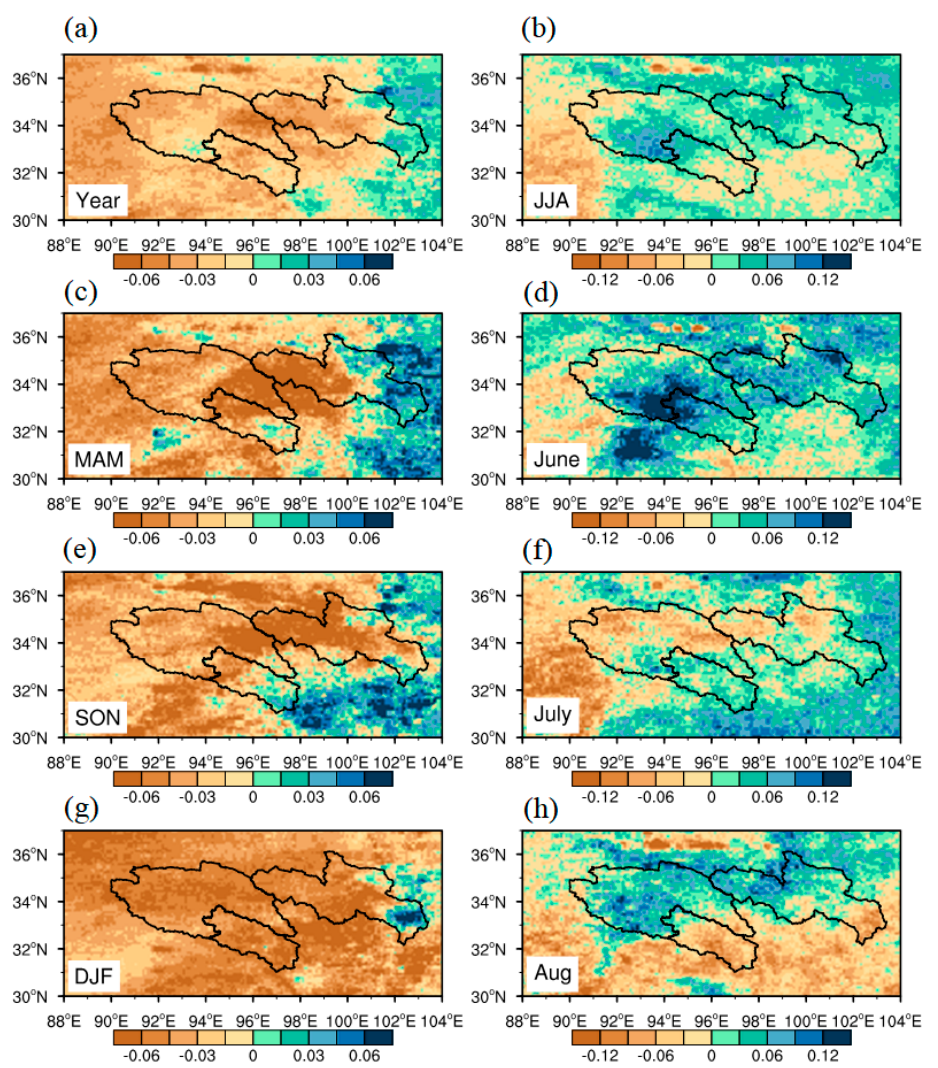
Figure 6. Difference in precipitation occurrence ratio between 2010 and 2019 and from 2001 to 2010 in ( a ) annual average, ( b ) June-July-August (JJA) average, ( c ) March-April-May (MAM) average, ( d ) June average, ( e ) September-October-November (SON) average, ( f ) July average, ( g ) December- January-Februrary (DJF) average, and ( h ) August